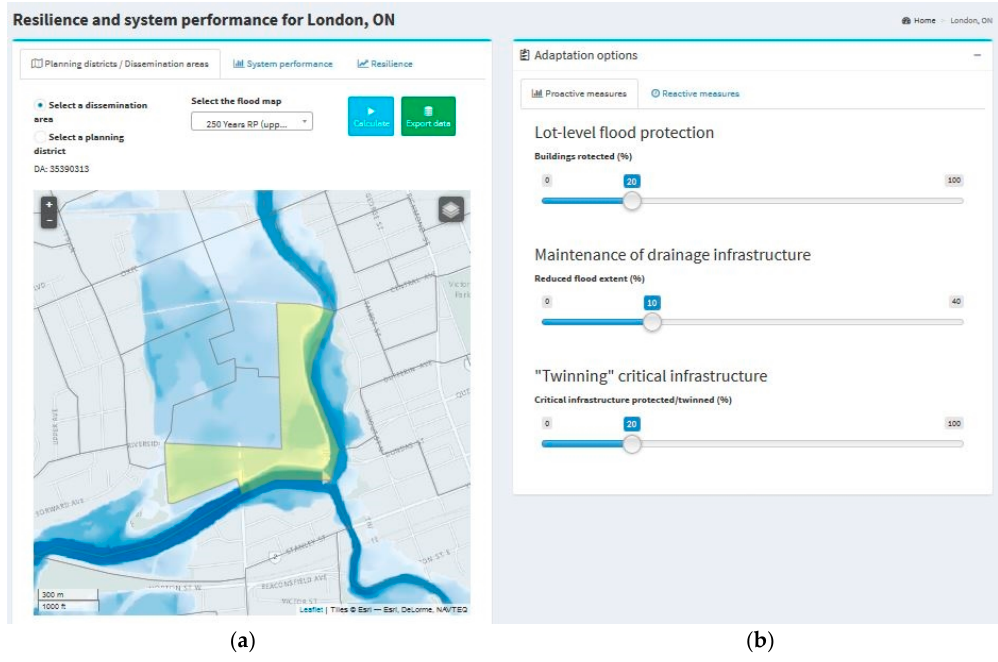
Figure 10. The ResilSIM tool user interface: the interactive map with spatial unit selection ( a ); and measures of adaptive capacity with interactive control sliders ( b ).